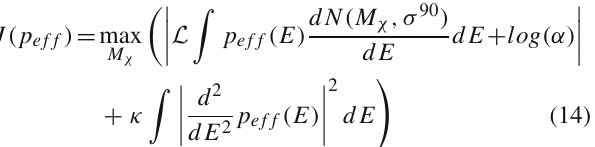
Fig. 2 Left: the reconstructed acceptances p 0 ( E ) compared to the XENON1T total ( p p 2 ef f sponding to SR1 from Fig. 1 in Ref. [1] (grey band). Right: the 90%